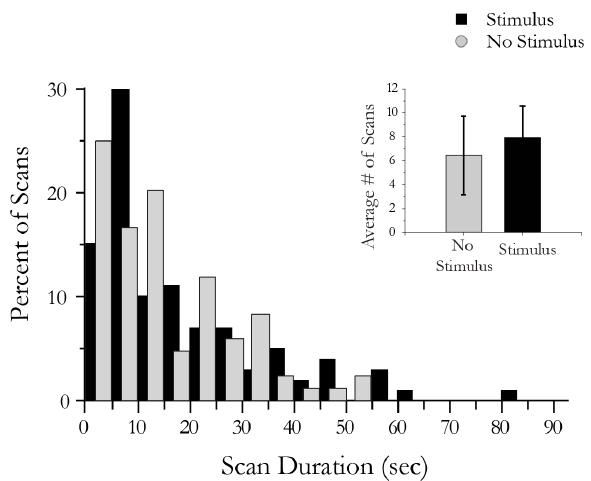
and for the same duration regardless of the presence or absence of a stimulus. The duration of scans is represented here for 99 scans from 18 individuals presented with a stimulus (black) and 84 scans in 18 individuals not presented with a stimulus (gray). We found no significant difference in scan duration when a stimulus was present (p . 0.7, Kolmogrov-Smirnov test). Inset: the average number of scans for a 5 minute trial in leeches with and without a vibratory (multimodal) stimulus. We found no significant increase in the number of searches when a stimulus was present (p . 0.74,